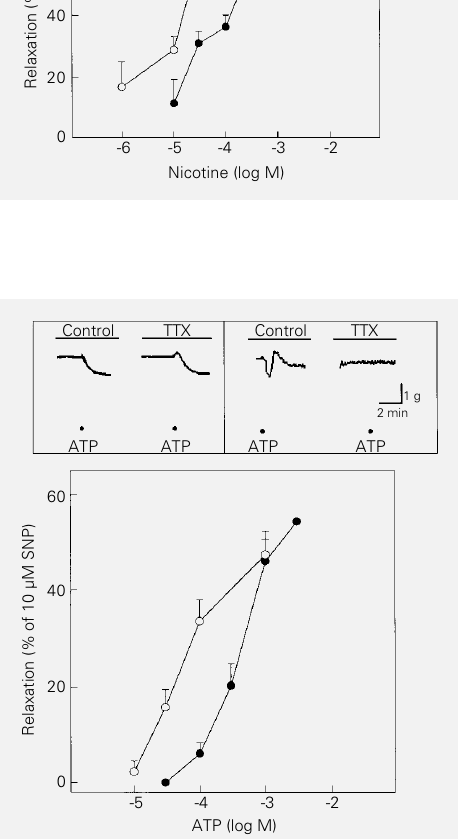
Figure 5 - Top , Representative tracings showing the response elicited by 100 µM nicotine on isolated lower esophageal sphincter (left) and ileocolonic junction (right) strips in the ab- sence or in the presence of 1 µM tetrodotoxin (TTX). Bottom , Relationship between the mag- nitude of relaxations induced by different concentrations (M) of nicotine in isolated lower esoph- ageal sphincter (filled circles) and ileocolonic junction (open circles) strips. Data are reported as the mean ± SEM (N = 6). The relaxation magnitude is reported as % of that obtained with so- dium nitroprusside (SNP). All ex- periments were performed in the presence of 1 µM atropine and 3 µM guanethidine.